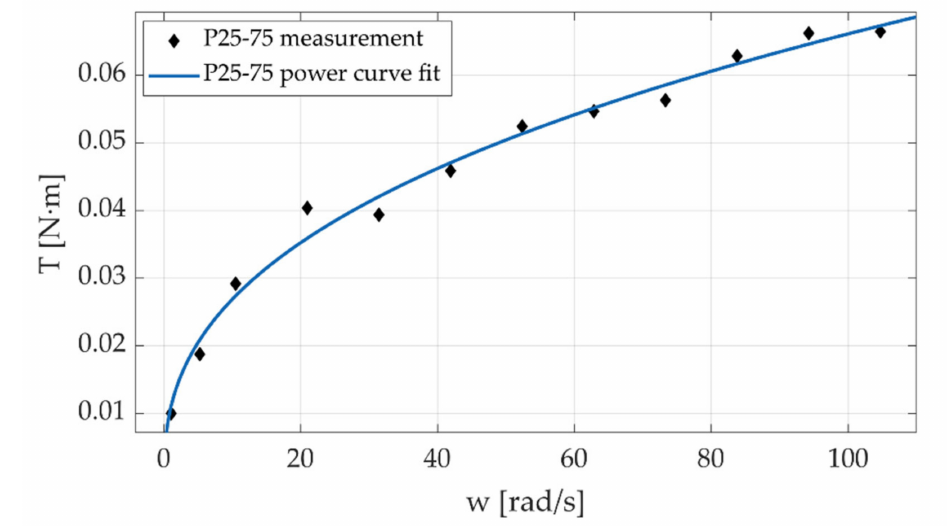
Figure 18. Friction torque of the cable-driven transmission 25–75